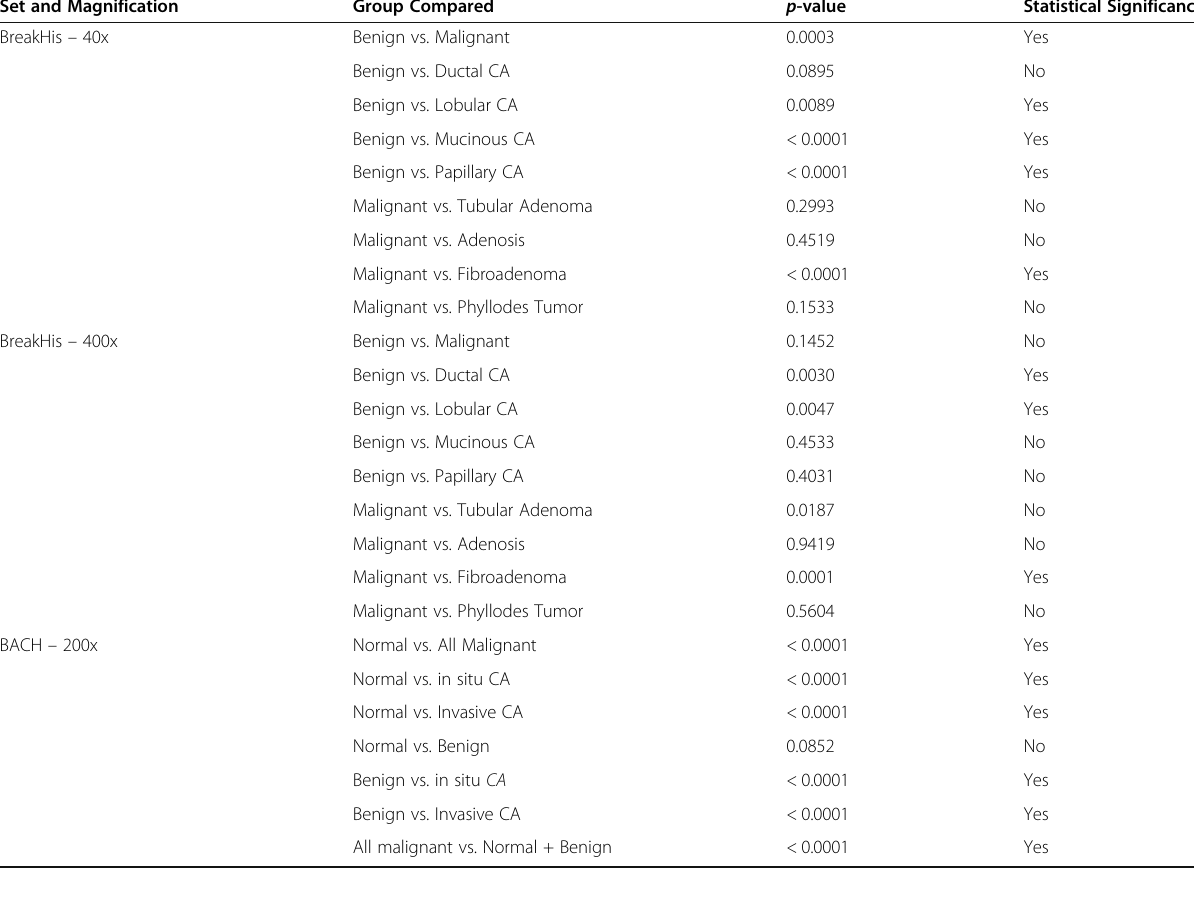
Table 3 Summary of the statistical analysis between each group inside each set and magnification Set and Magnification